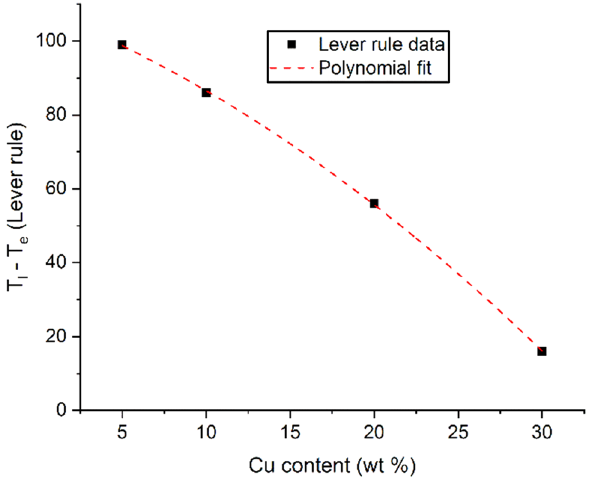
Fig. 6 Plot of temperature difference between liquidus and eutec- tic temperature based on the Lever rule for Al-Cu binary alloys as a function of the Cu content (in wt